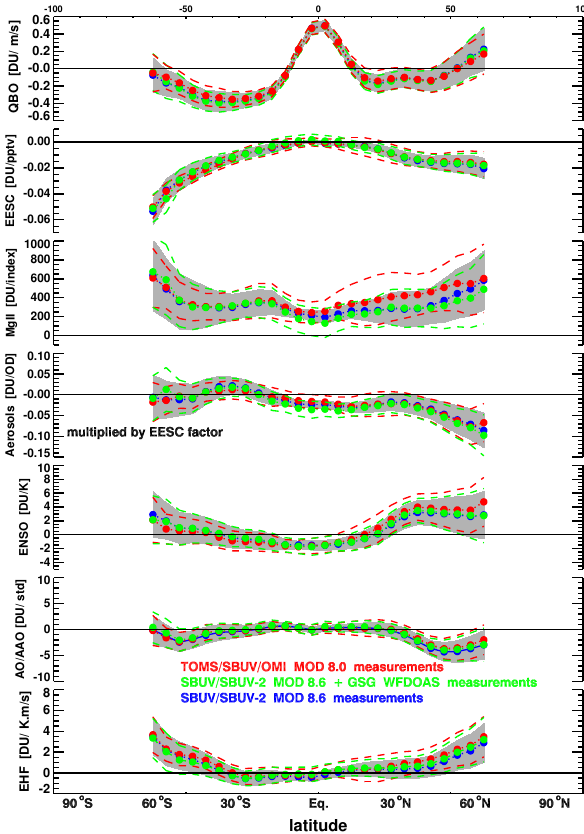
Figure 8. The fitting coefficients of the different explanatory vari- ables used in the regression analysis of the different merged data sets. The statistical significance at two sigma level is displayed in respective colours as in Fig. 7.